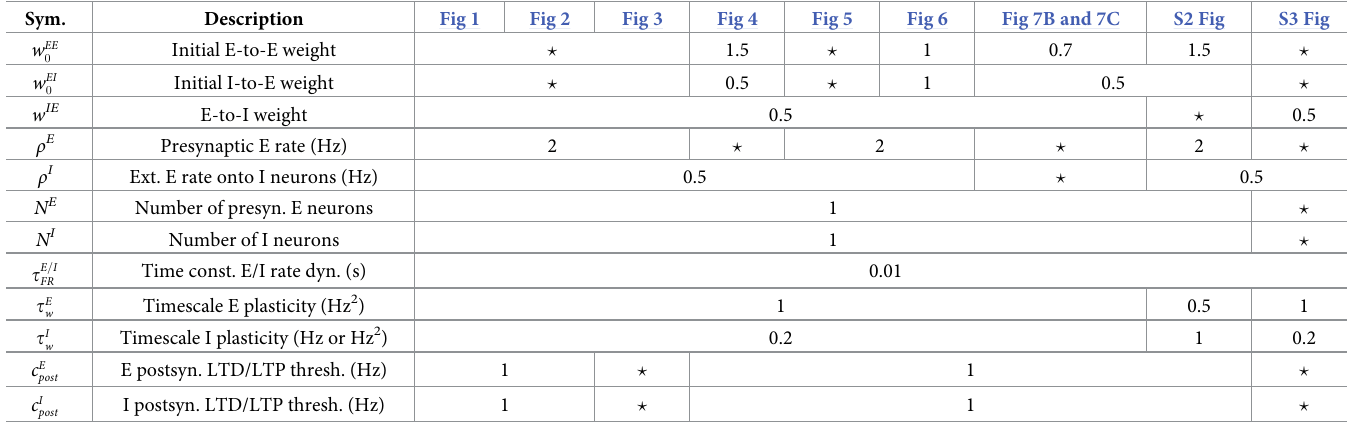
Table 1. Parameter values for figures, ? denotes that values are provided in the figure captions. Sym.